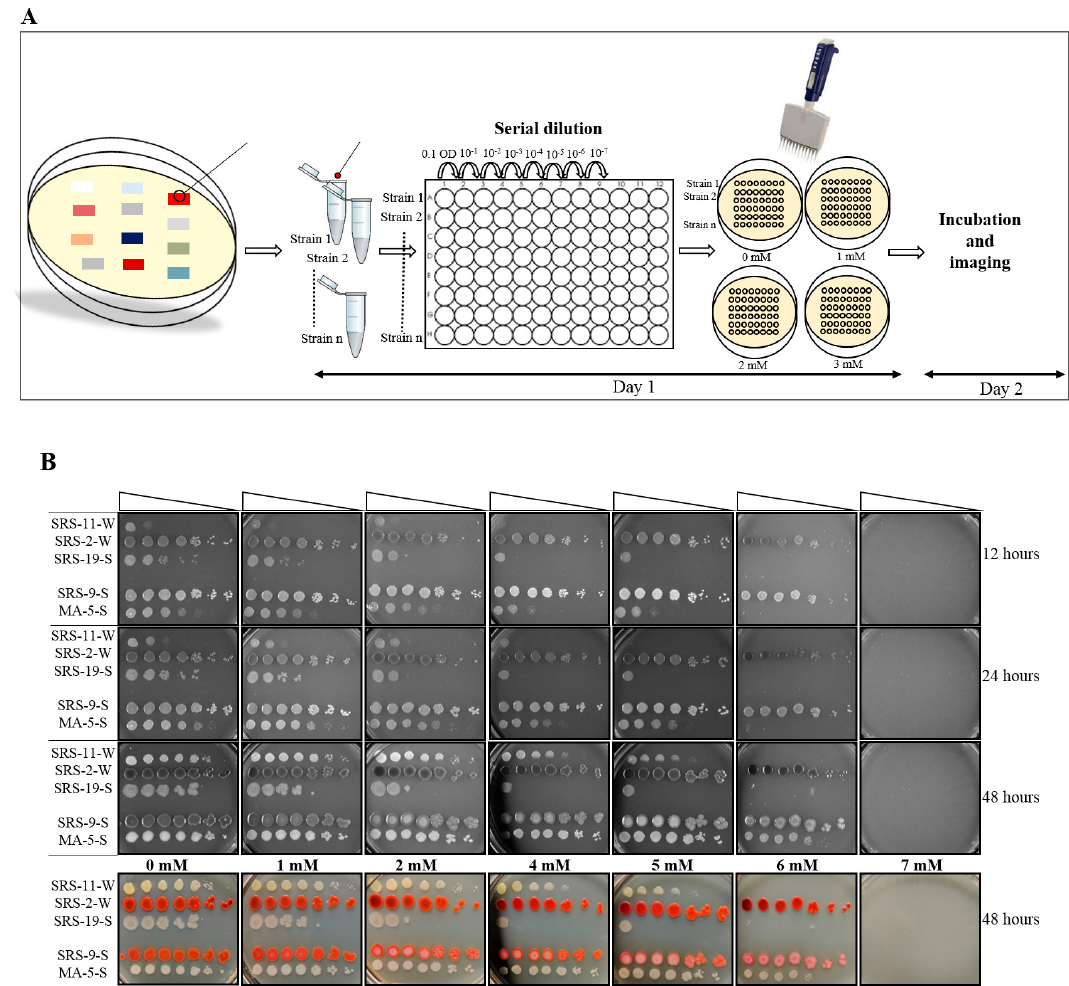
Figure 1. The MIC determination for bacterial isolates against uranium. ( A ) Schematic of plate MIC method. ( B ) Represents the images from plates taken at 12, 24, and 48 h. The U concentration was used from 0 to 7 mM. The procedure was followed as shown in the schematic and described in Materials and Methods, Section 2. The last panel shows colored images at 48 h. Strain names are mentioned on the left of each plate. The experiments was performed in triplicates, and the data shown is a representative image.